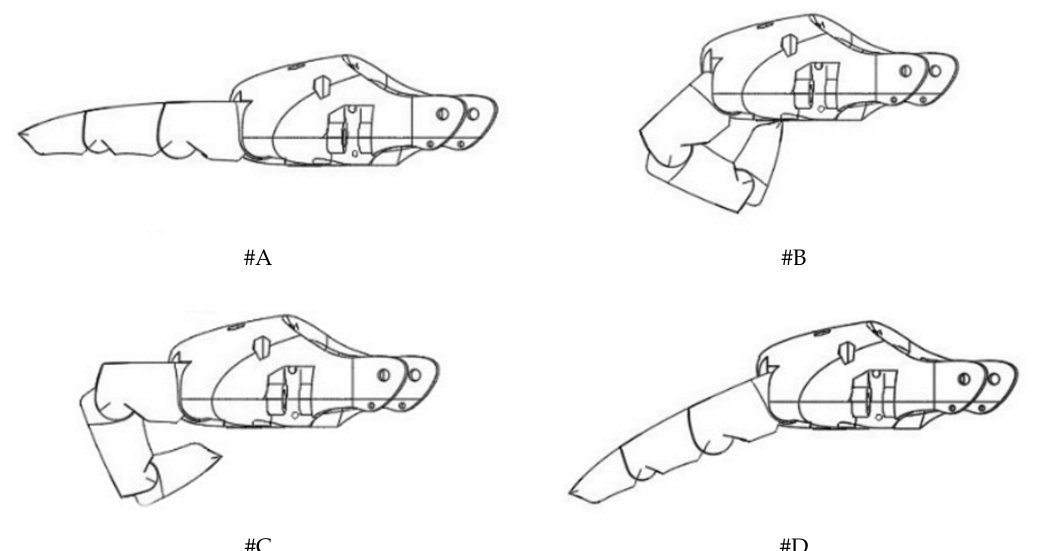
Figure 4. The final positions of the robotic finger for the considered motions #A–#D, according to the description in Table